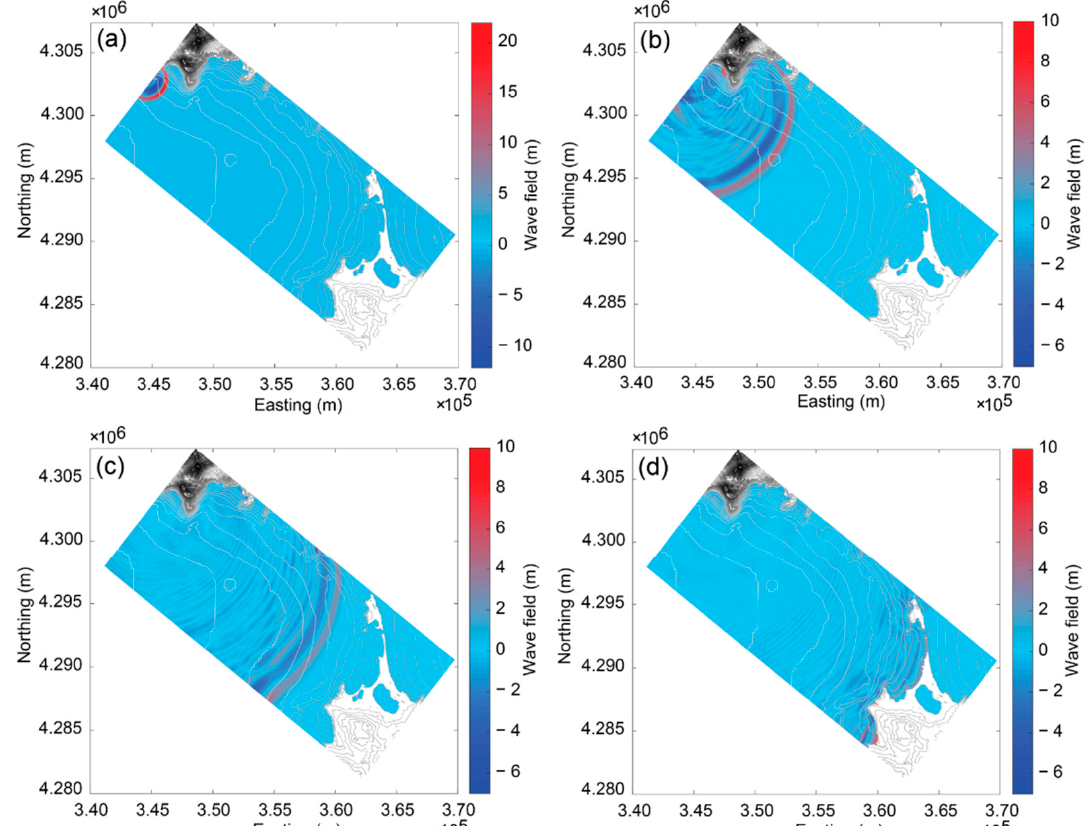
Figure 12. Time history of wave propagation in scenario 2 at ( a ) t = 65 s, ( b ) 305 s, ( c ) 605 s, and ( d ) 905 s.